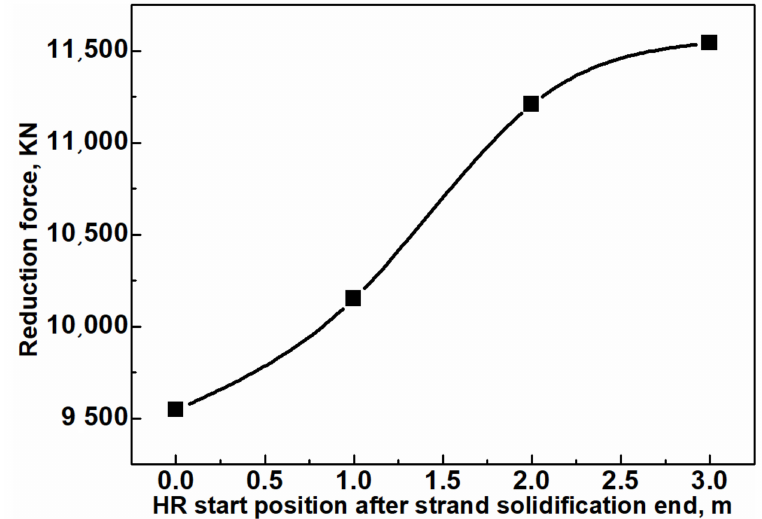
Figure 16. The required reduction force for the HR segment to implement 6% HR deformation at different strand position.